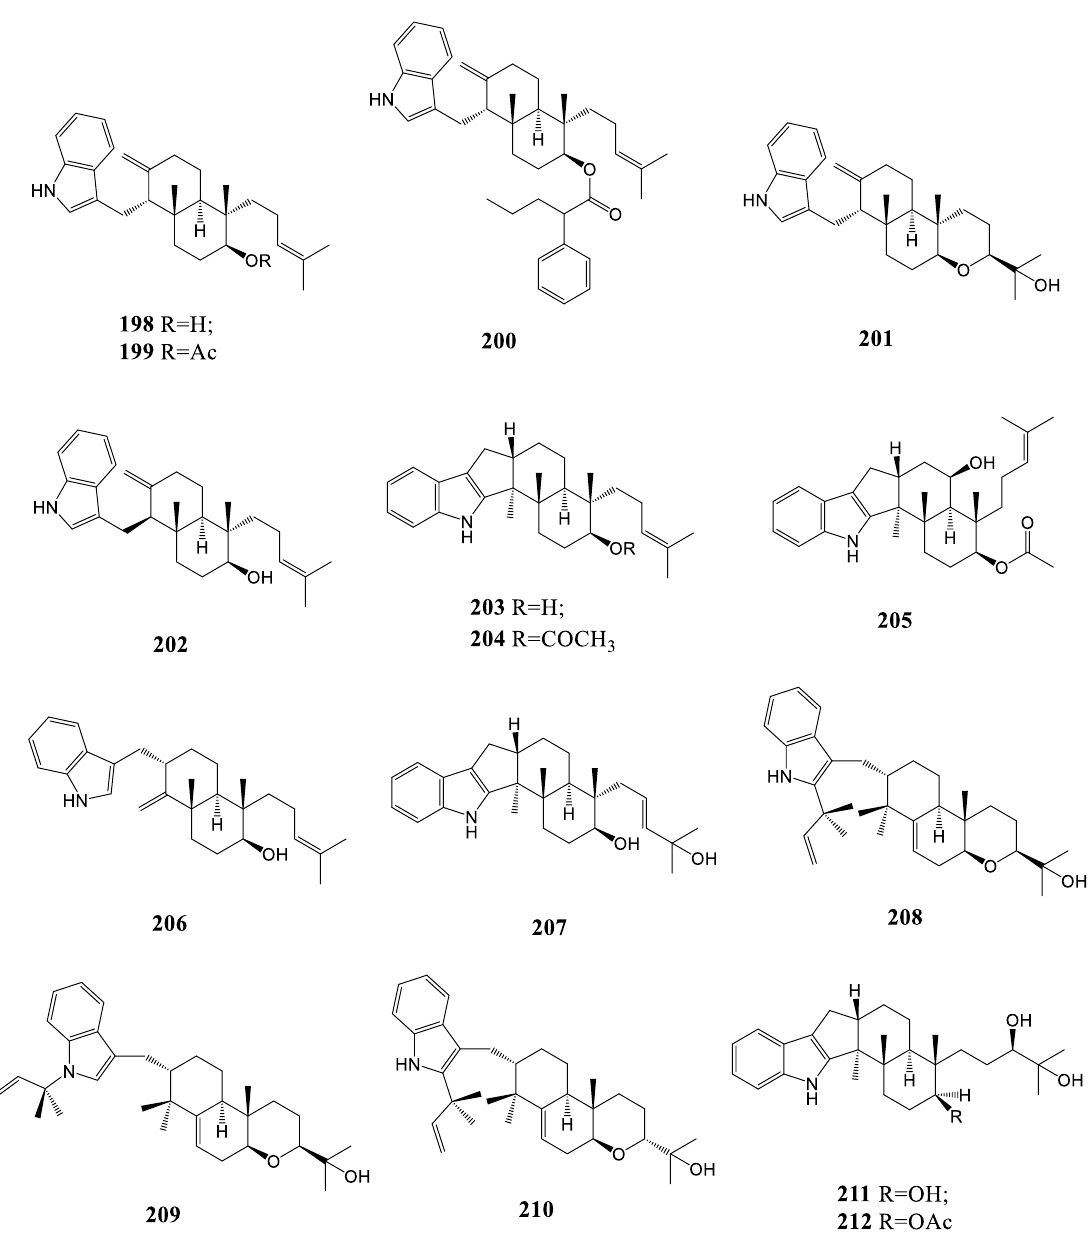
Figure 10. Emindole-like indole diterpenoid compounds.